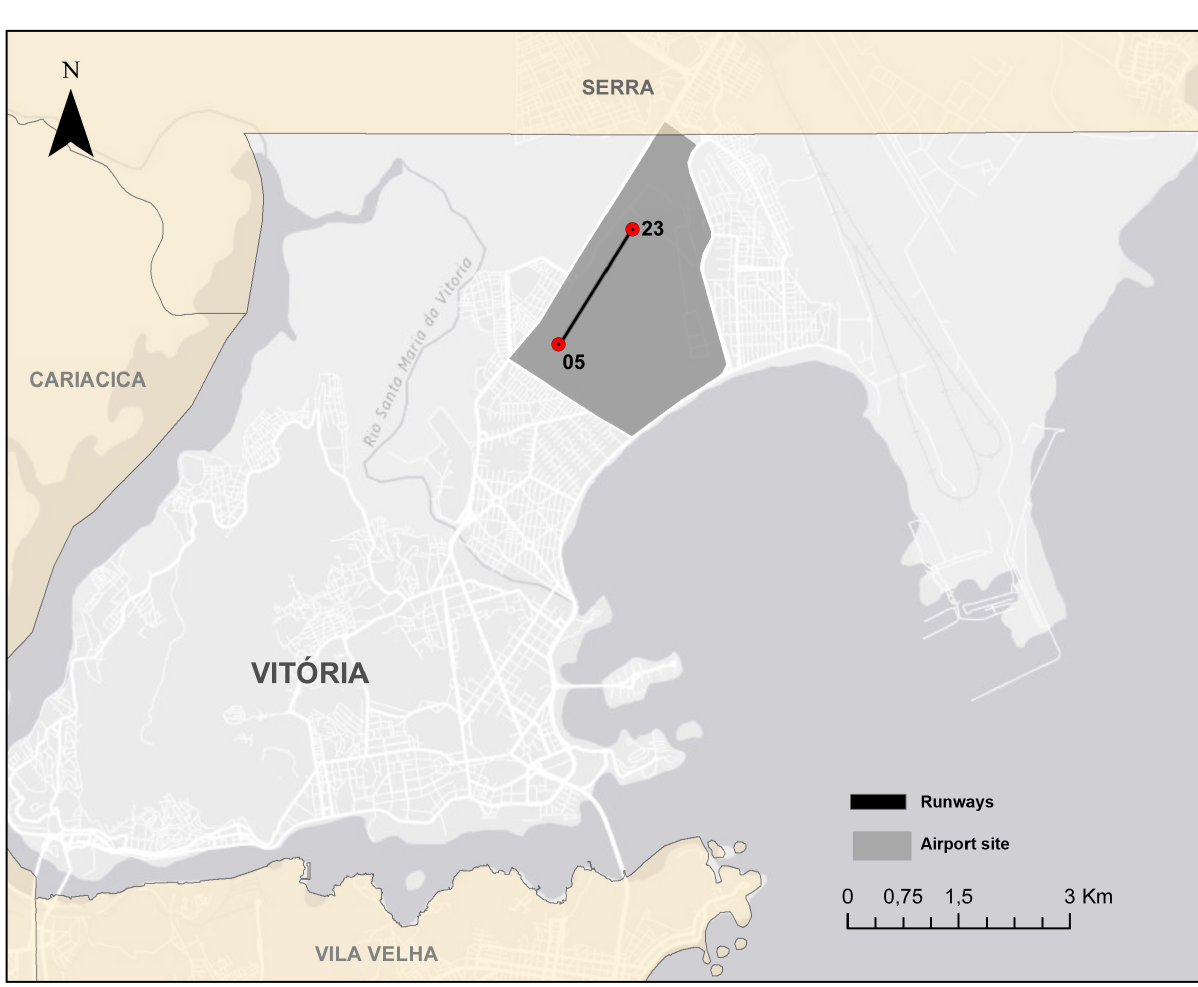
at a height of approximately 1.20m from the ground, in ac- cordance to NBR 10151